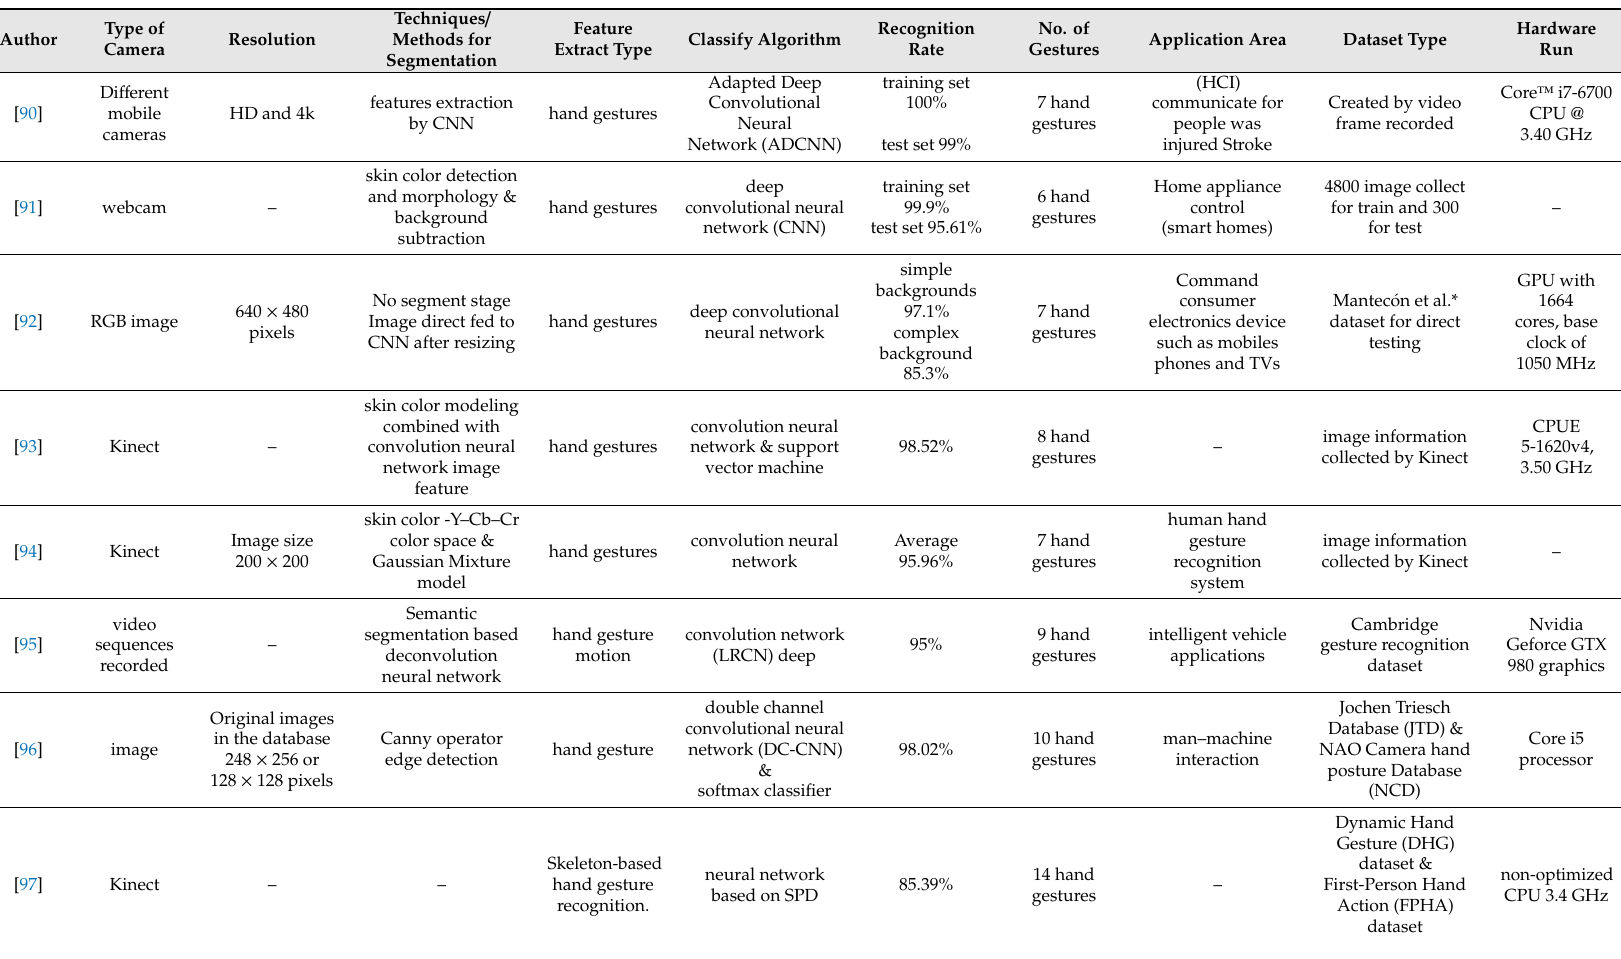
Table 7. Set of research papers that have used deep-learning-based recognition for hand gesture